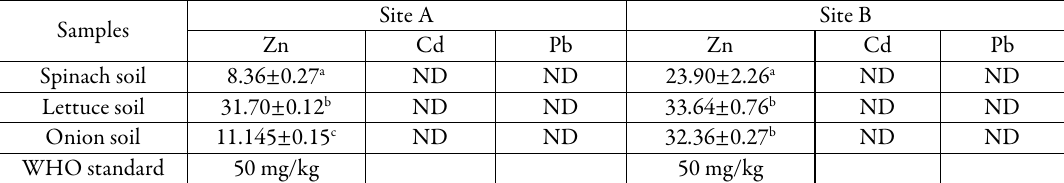
Table 2. Heavy metal concentration (mg/kg) of soils receiving wastewater Site A Site B Samples Spinach soil Lettuce soil WHO standard 50 mg/kg 50 mg/kg NB: Mean±SD (in the same column) with different letters in superscripts differ significantly (p<0.005). ND implies not